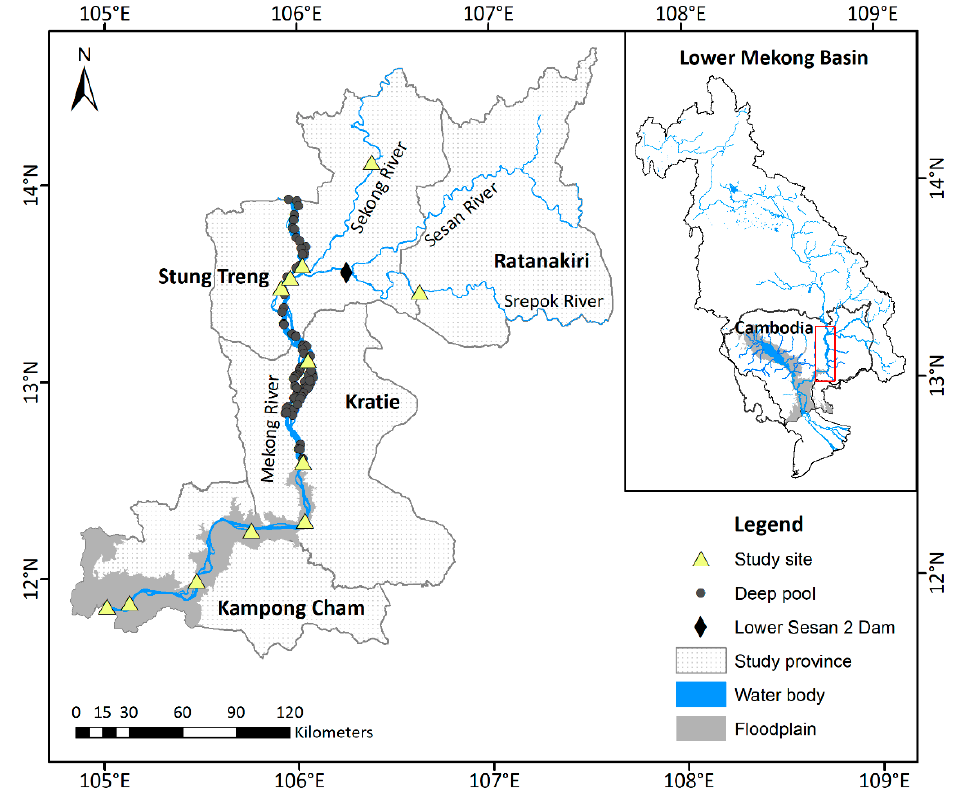
Figure 1. Map of the Mekong, Sekong, Sesan, and Srepok rivers within the study area in northern Cambodia. Water bodies indicate permanent rivers and lakes, while the floodplain indicates seasonally-inundated areas. Deep pool depths range from approximately seven to 80 m. Land cover data were provided by the Mekong River Commission (MRC); these data were published in the MRC technical reports [47,48] and were reproduced with permission from the MRC. Three coarse habitat types were represented in this survey: floodplain, pool, and